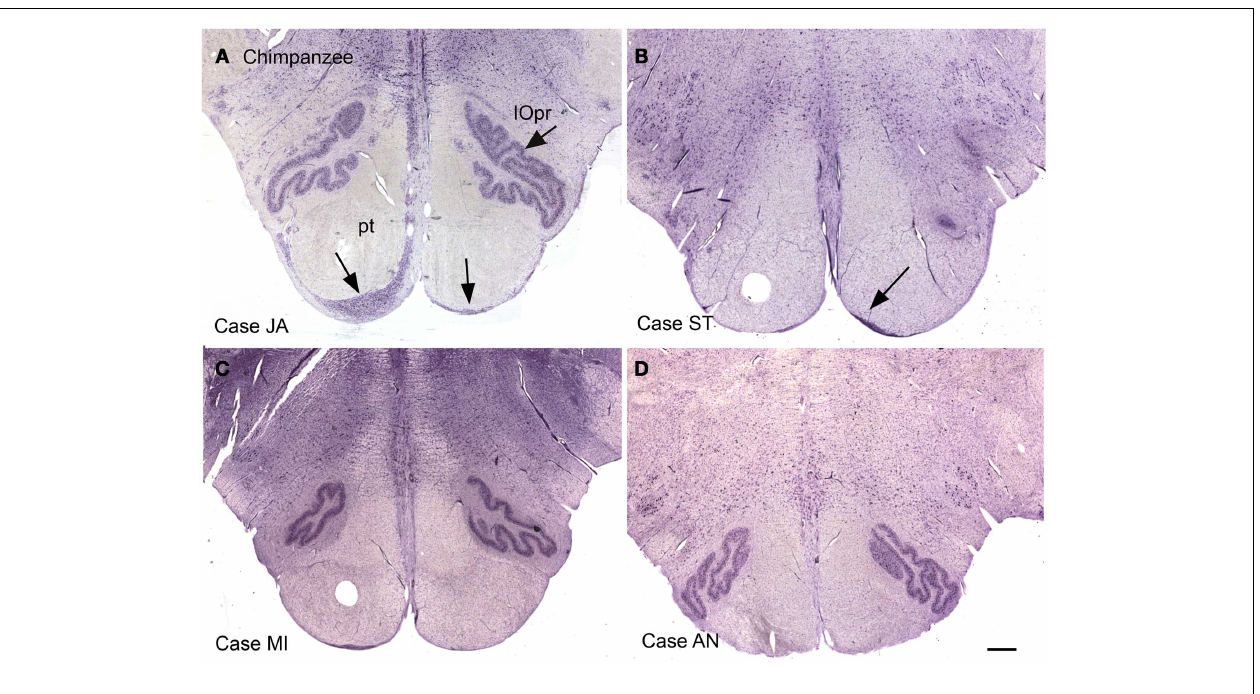
FIGURE 12 |The ventral medulla in the chimpanzee, Cases JA (A), ST (B), MI (C), andAN (D) . (A) The arrows show stained cells ventral to the pyramidal tracts in the expected location of the arcuate nucleus.